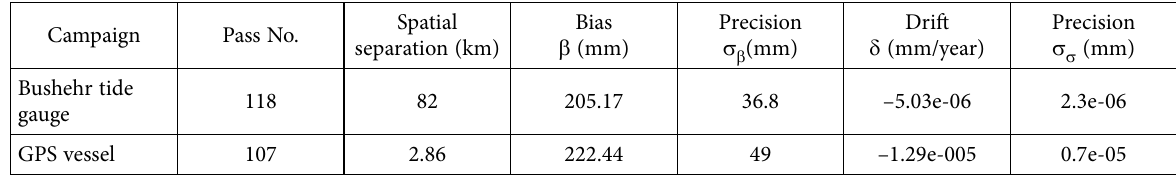
Table 9. Bias, drift and annual/semiannual constituents of jason-2 estimated by the coastal tide gauge stations at Bushehr port